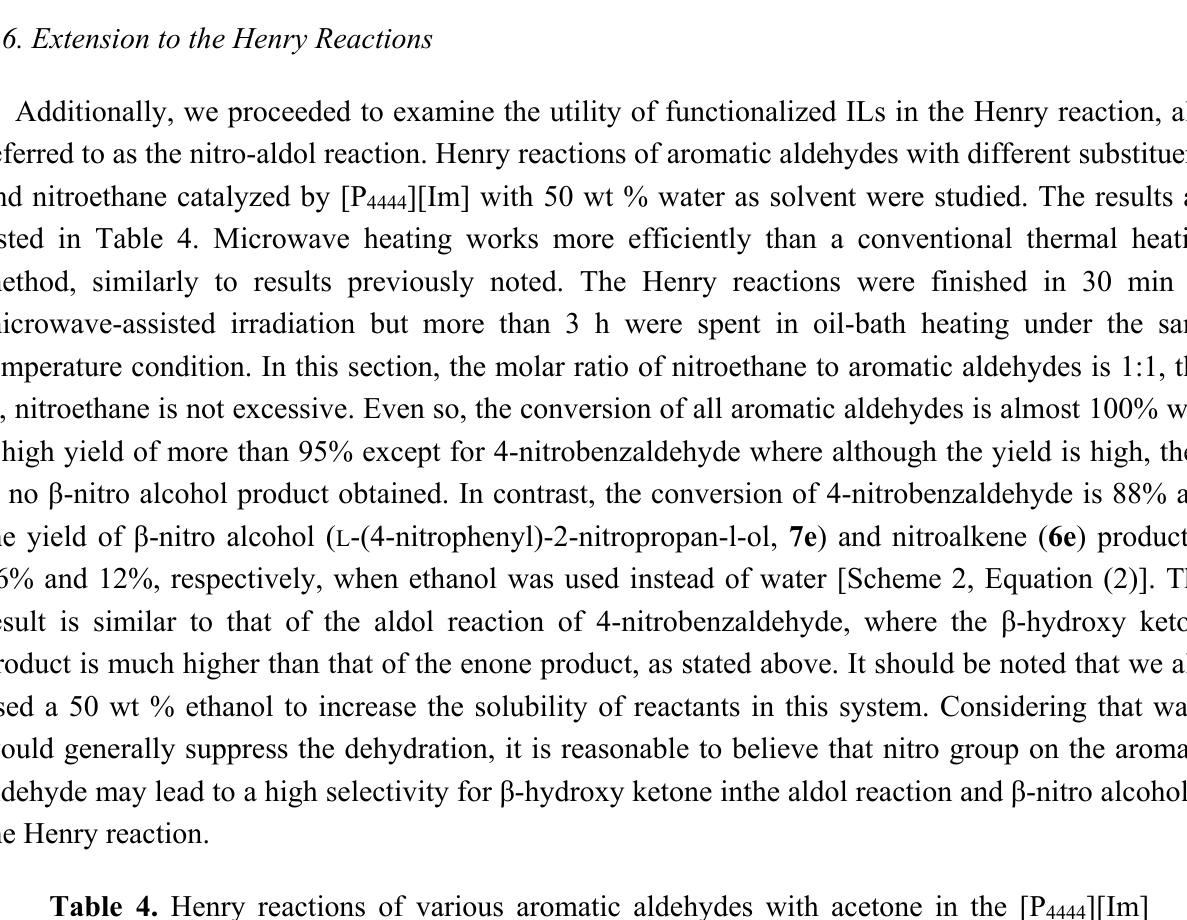
Table 4. Henry reactions of various aromatic aldehydes with acetone in the [P catalytic systems. Reaction conditions: 3.4 mmol ILs, 50 wt % of H